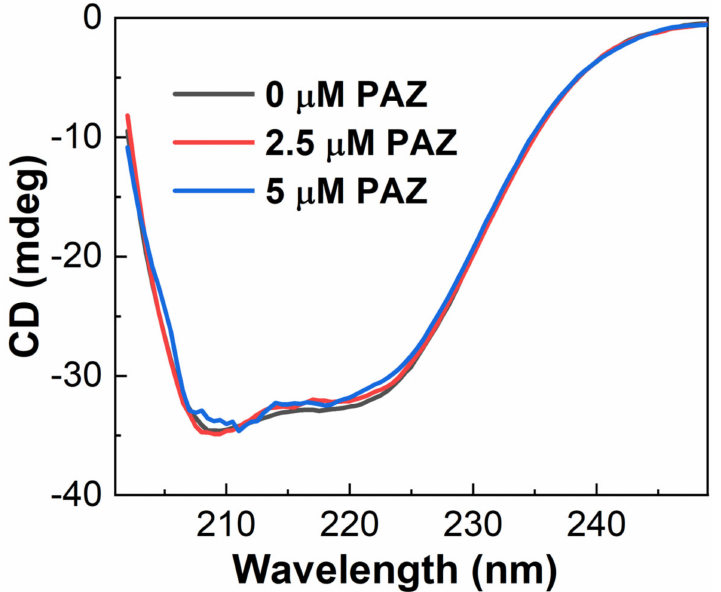
Figure 8. Far-UV CD spectra of 2.5 µ M HSA in Tris-HCl buffer solution (pH 7.4) in the absence and presence of 2.5 µ M and 5 µ M PAZ.